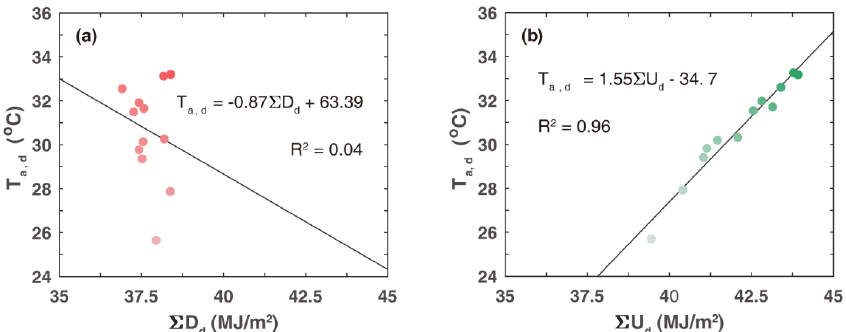
Figure 6. The daily near-ground air temperature (T a,d ) uncorrected with ( a ) Σ D d , and ( b ) increasing linearly with Σ U d .